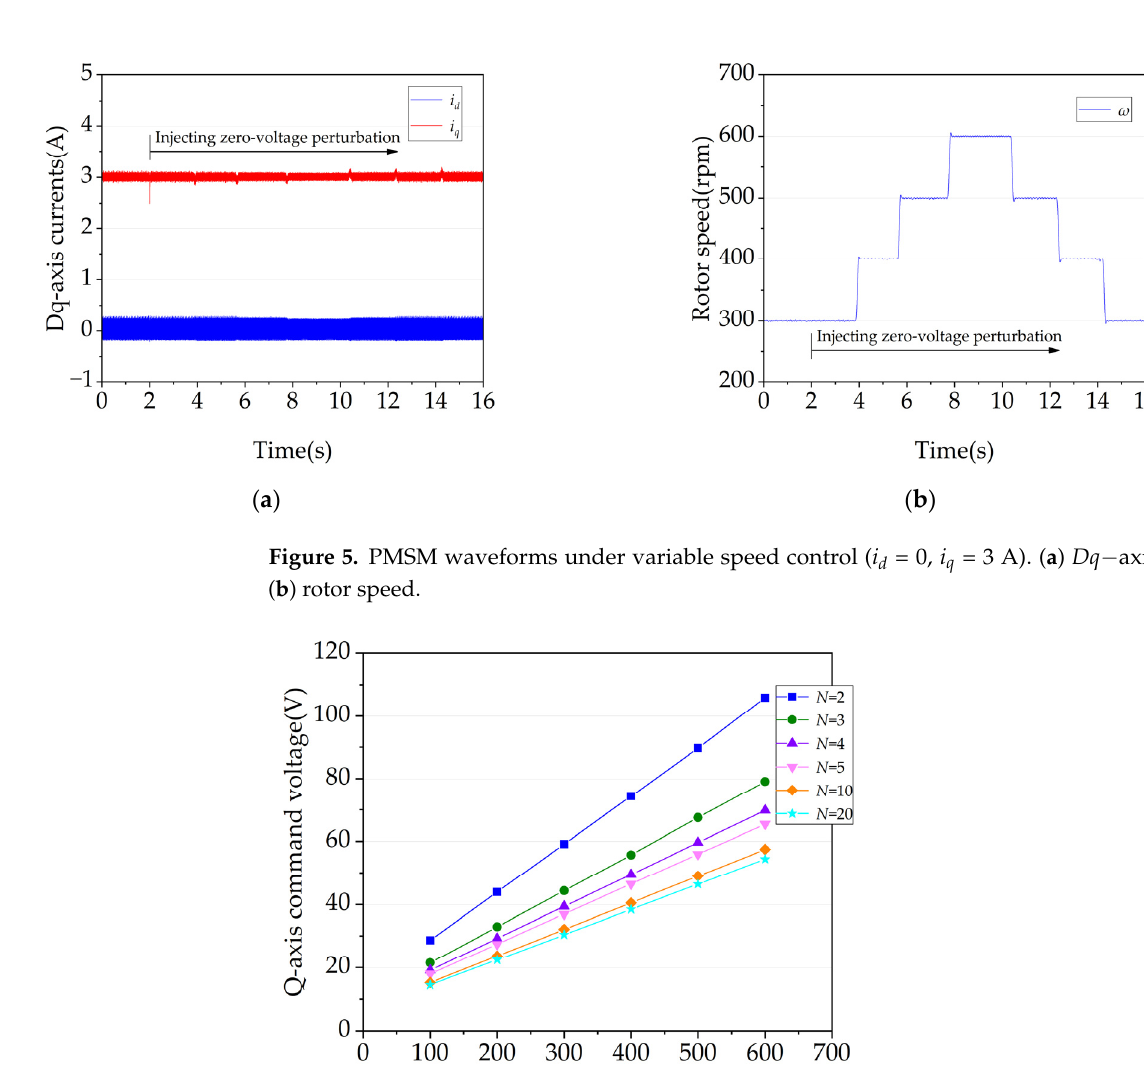
Table 3. Estimated rotor flux linkage value under different winding